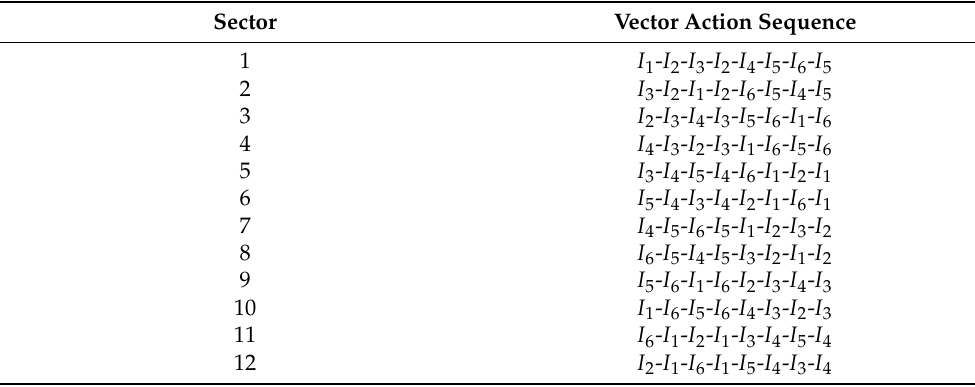
Table 3. New scheme partition and vector action